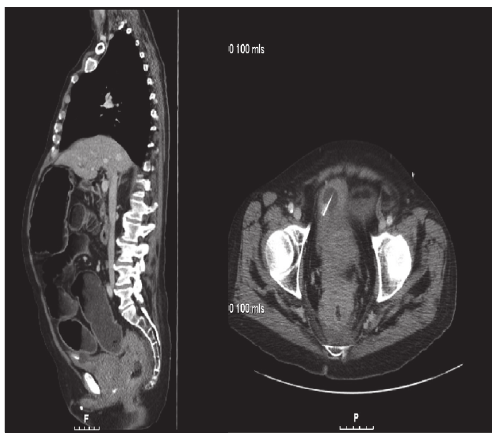
Figure 1: A sagittal and coronal view showing an advanced prostatic cancer involving